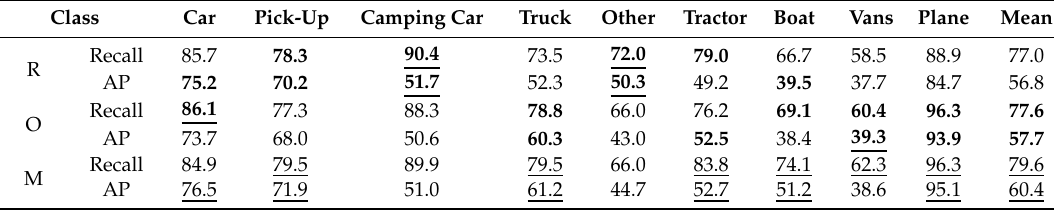
Table 7. Detection accuracy of proposed algorithm for OBB in three di ff erent types of datasets. Class